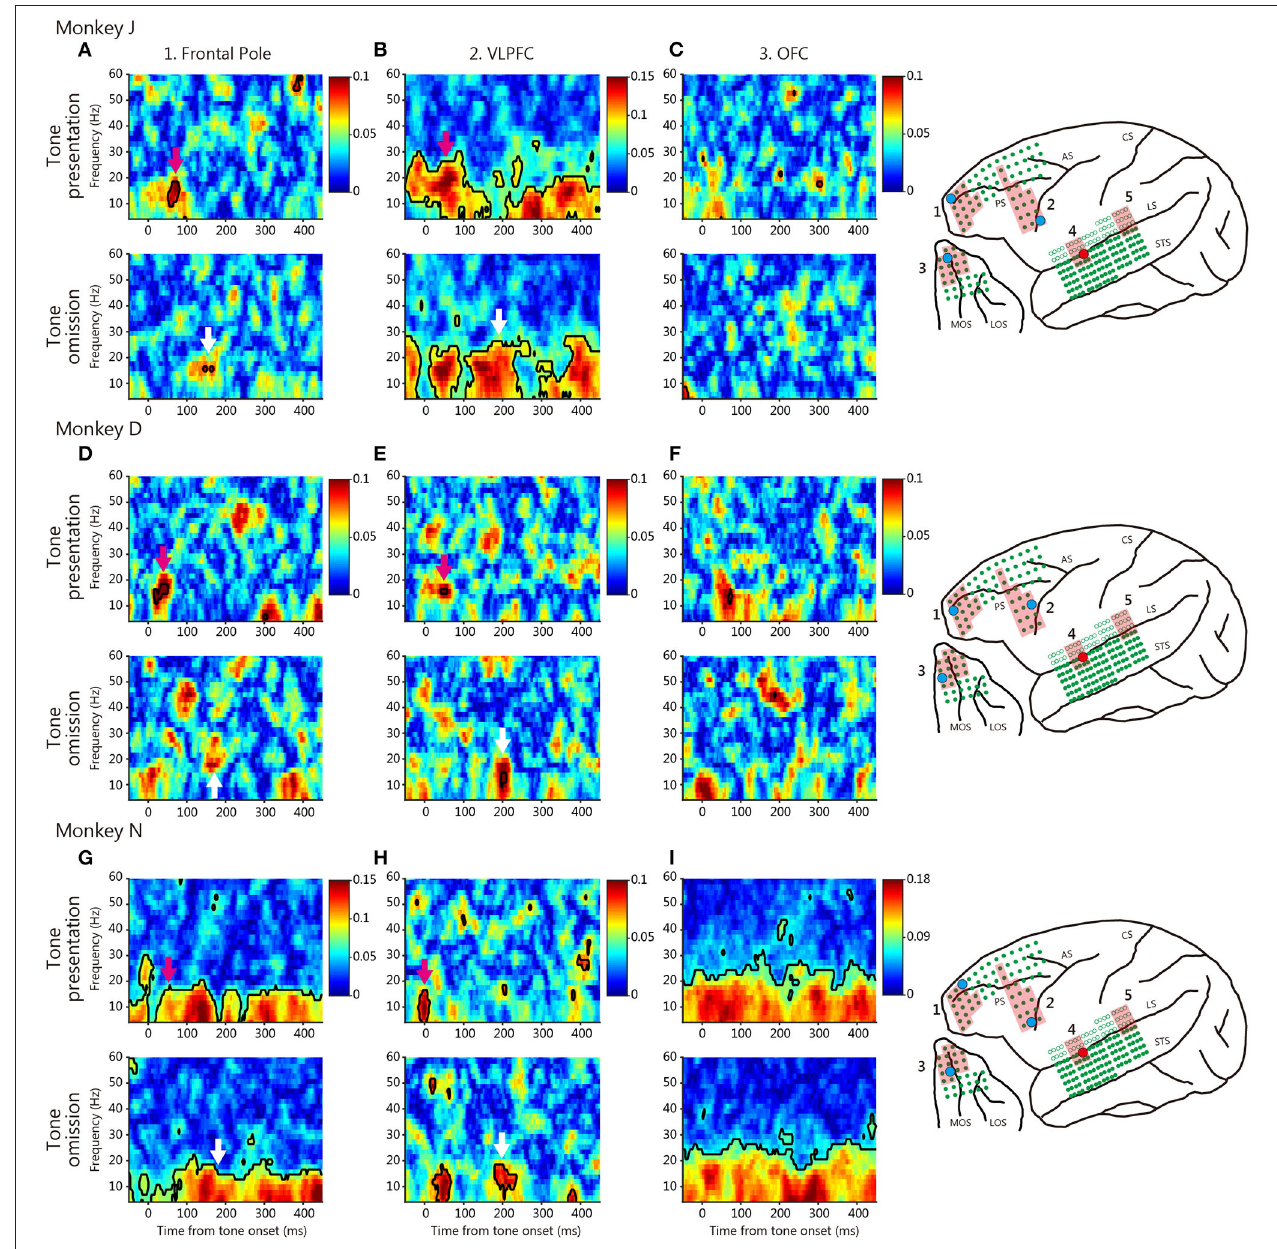
FIGURE 3 | Typical phase-locking values (PLVs) between the anterior temporal cortex and various prefrontal cortical regions. The red dot on the brain map indicates the seed electrode, and the cyan dot indicates the target electrode. The red shaded regions indicate the defined area of the target electrode positioned. (A–C) PLVs of monkey J. The PLV map of each area is between the anterior temporal cortex electrode and the frontal pole (A) , the VLPFC (B) , and the OFC (C) electrodes, in terms of tone presentation (above) and tone omission (bottom). Black contoured lines indicate statistically significant PLVs (Rayleigh test, p < 0.05, FDR-corrected). Colored arrows indicate important patterns of PLVs in each tone. Color scales were identical for tone presentation and tone omission, but were different across area and monkey. (D–F) PLVs of monkey D. (G–I) PLVs of monkey N.